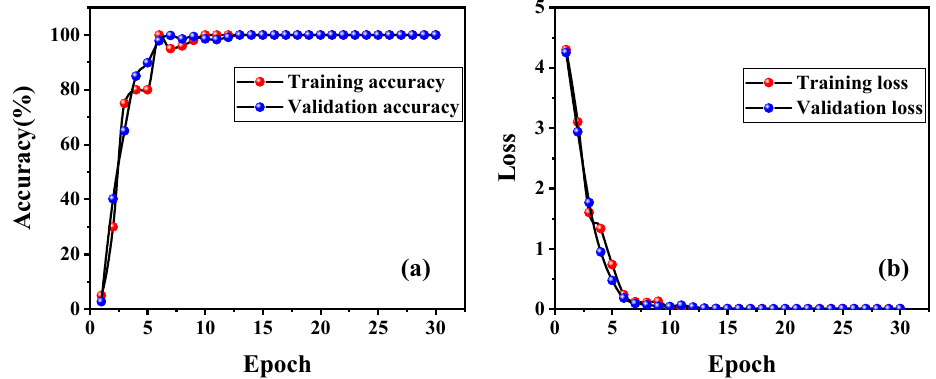
Figure 6. Learning curve of model based on Resnet18 architecture. (a) The training accuracy is plotted as a function of epochs. (b) The relationship between loss and epochs.